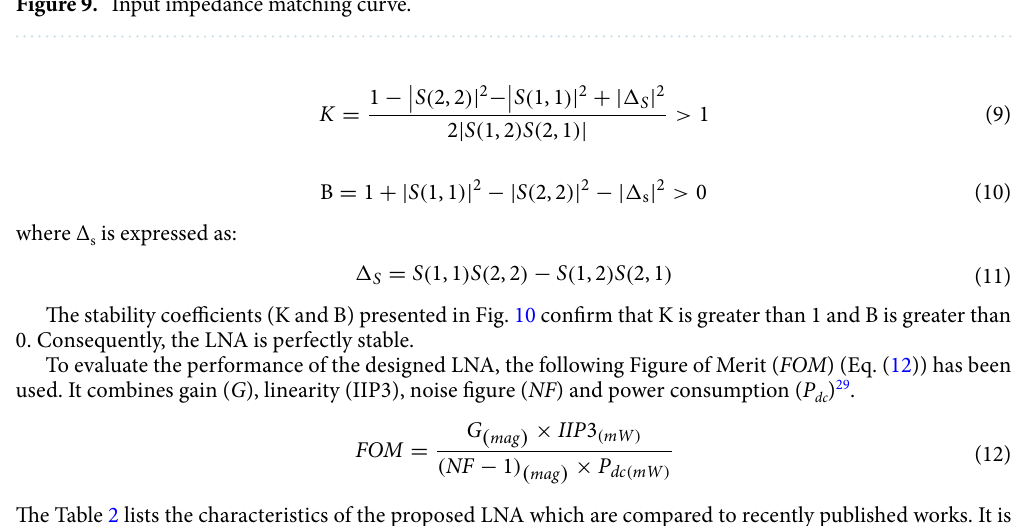
Figure 9. Input impedance matching